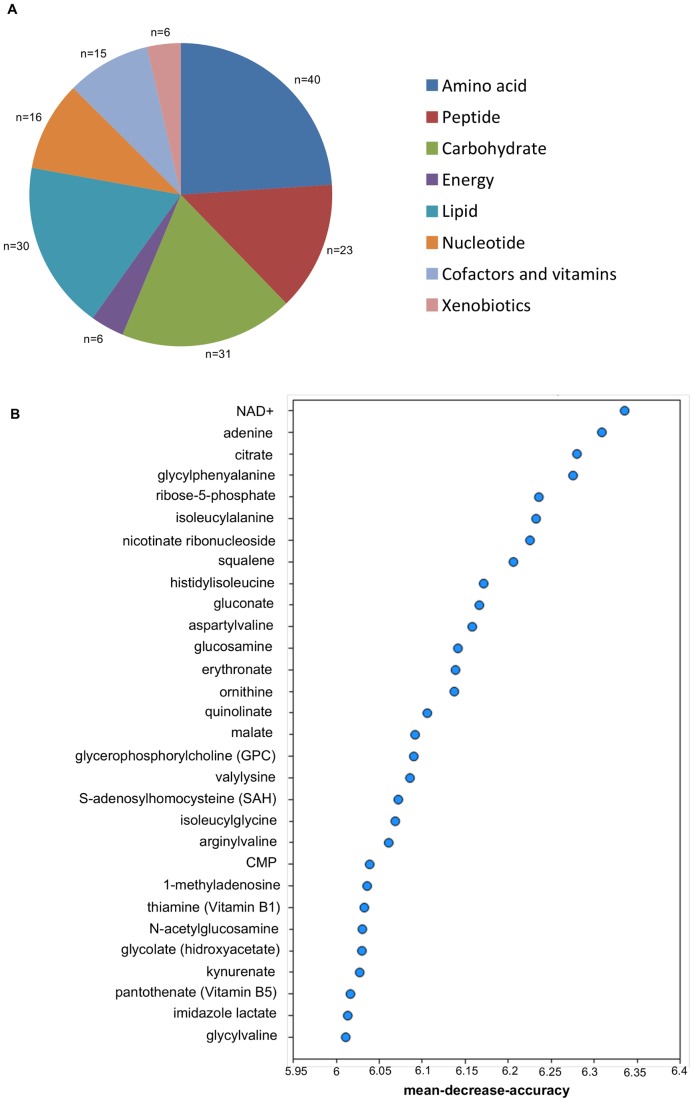
Principal metabolic differences between S. cerevisiae and S. kudriavzevii growing at 12°C.A) Class distribution of the different identified metabolites. n  =  number of metabolites in each class. B) The Random Forest statistical analysis of metabolomic data was used to identify the top 30 biochemicals with the greatest influence in distinguishing the different groups. Metabolites are listed on the y-axis in order of importance, with importance decreasing from top to bottom. The mean decrease in accuracy for each metabolite is plotted on the x-axis.